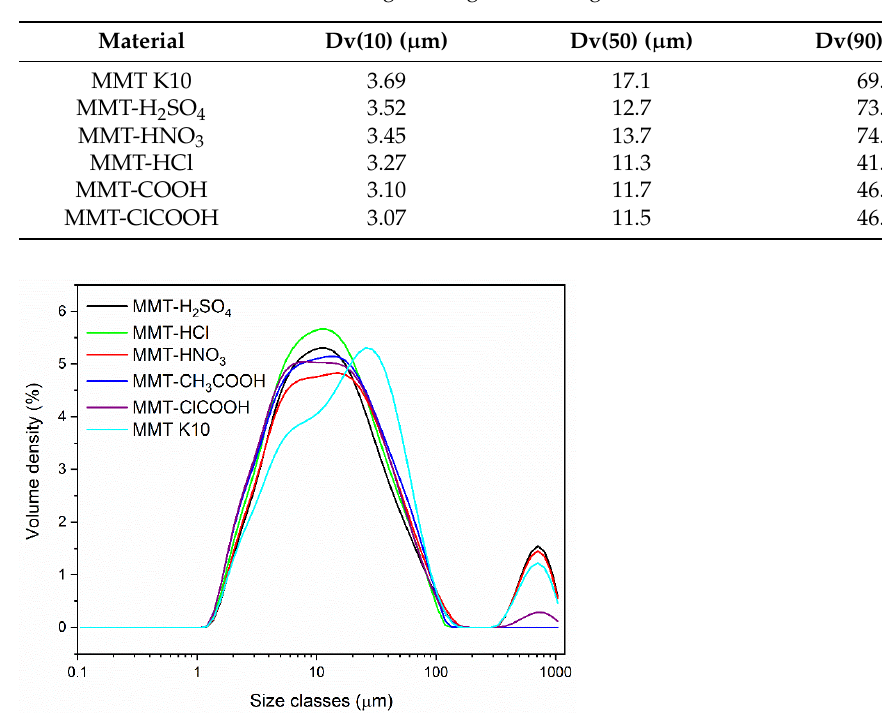
Table 4. Particle sizes measured using laser light scattering.